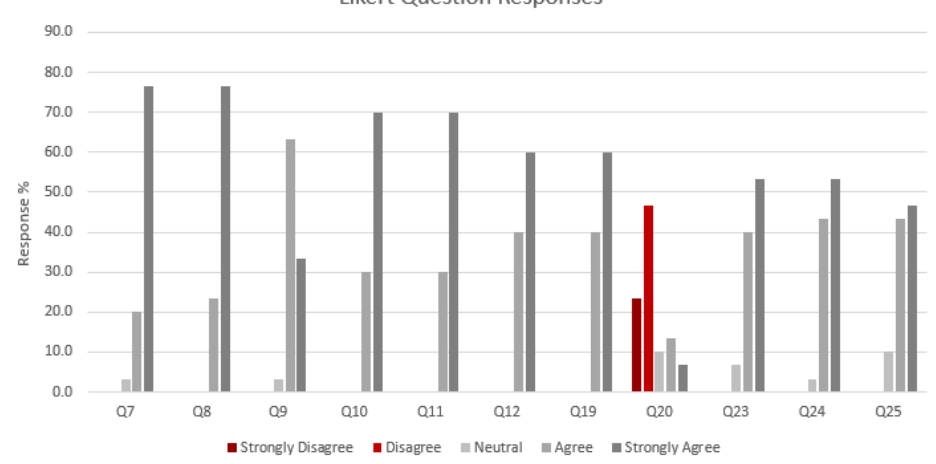
Figure 7. Likert scale